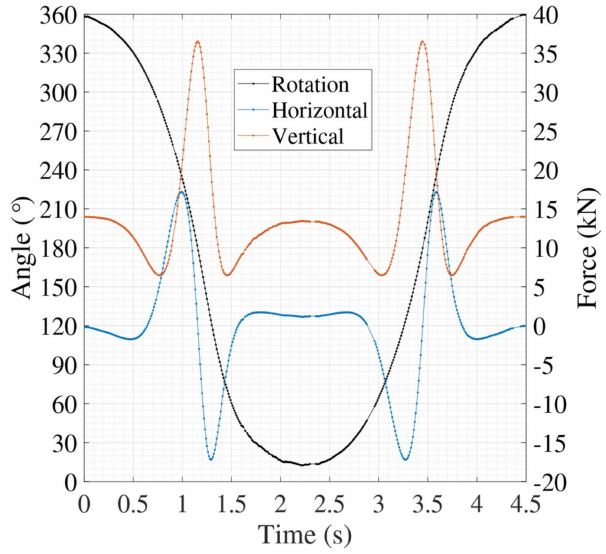
Figure 11. The angular rotation and horizontal and vertical forces of bell ten against